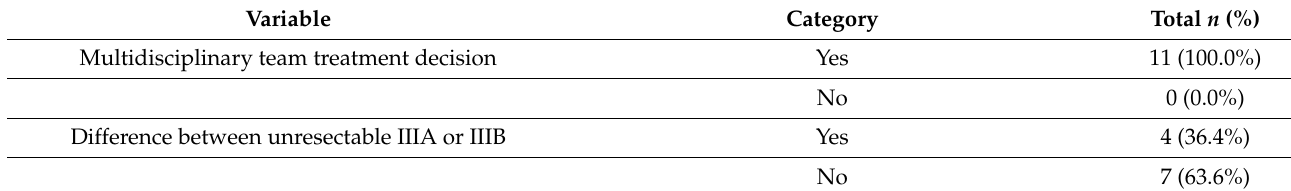
Table 2. Current practices for stage III NSCLC treatment with